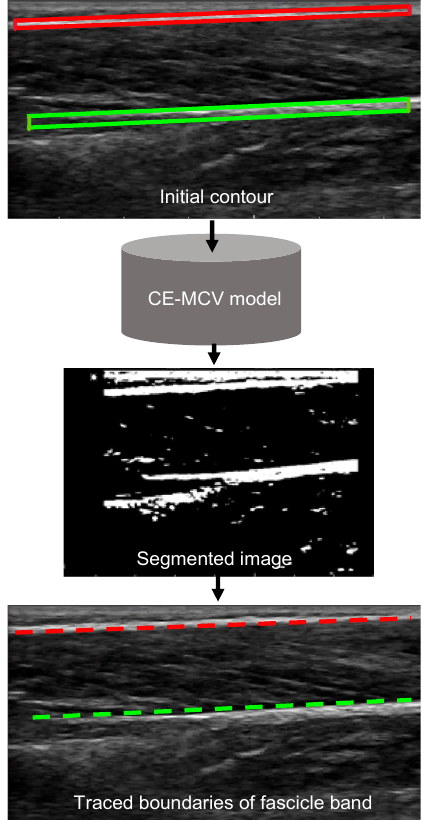
Figure 4. Tracing of top (red) and bottom (green) boundaries of the fascicle band. Particle filter: The tracking of the aponeuroses is posed as a state estimation problem